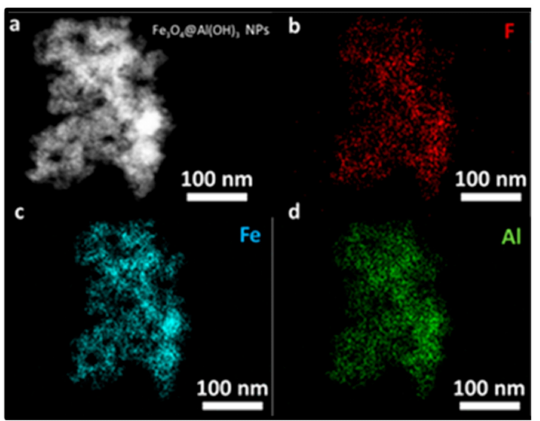
Figure 8. ( a ) STEM micrograph and mapping with EDX emitted by the elements present in the fluoride loaded Fe 3 O 4 @Al(OH) 3 samples: ( b ) fluoride, F ( c ) iron, Fe, and ( d ) aluminum,